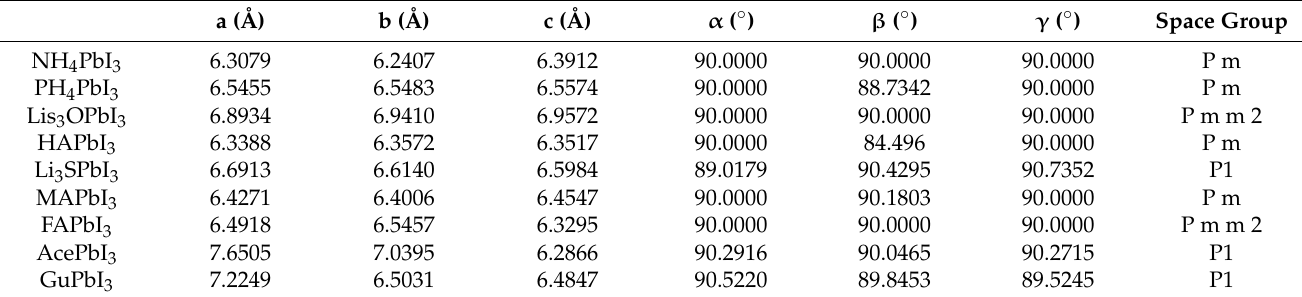
Table 1. The theoretical lattice constants a, b, c, α , β , γ , and space groups of A i PbI 3 with the different cations.